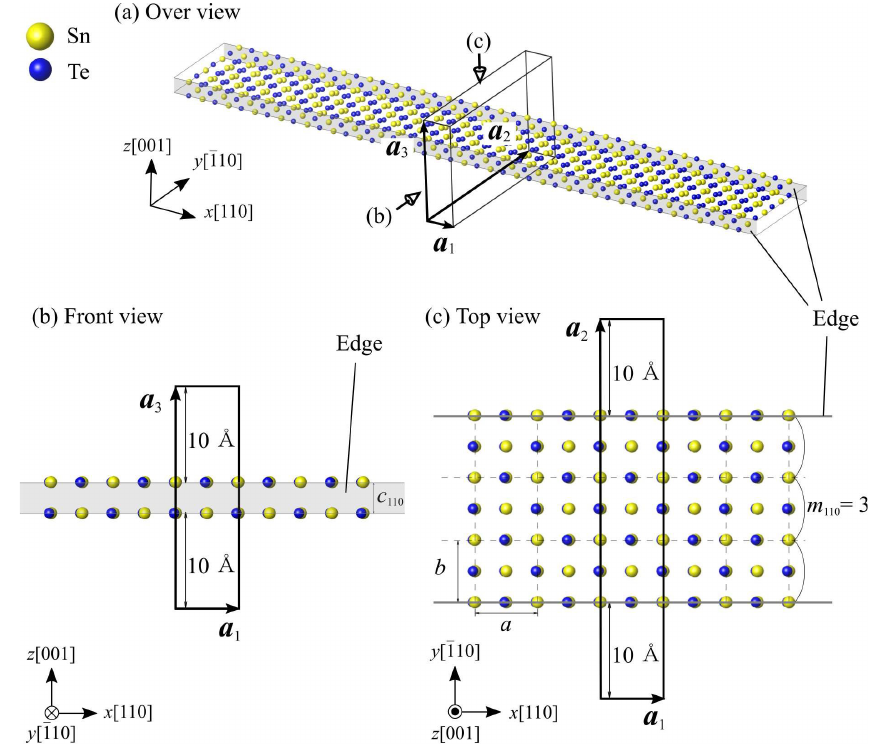
Figure 2. Simulation models of SnTe nanoribbon with 3-unit-cells width. The gray area and solid lines indicate edges of SnTe nanoribbon. The solid boxes represent the simulation cells. a 1 , a 2 and a 3 indicate the simulation cell vectors.